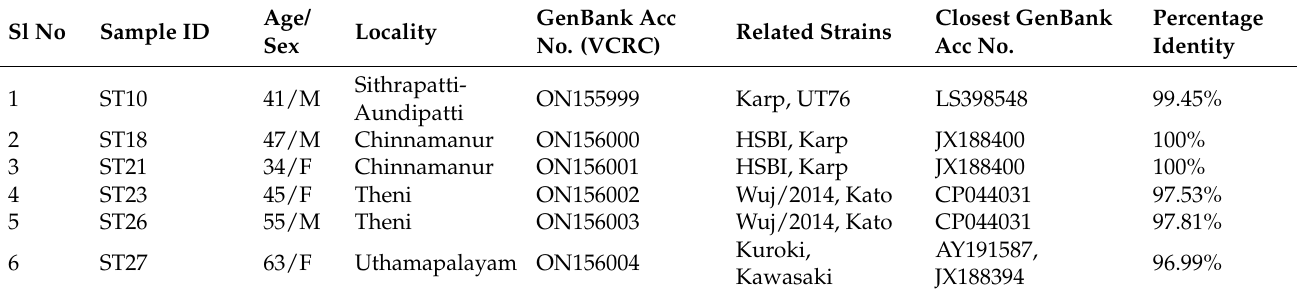
Table 1. The sample details and GenBank accession numbers of the O. tsutsugamushi detected in this